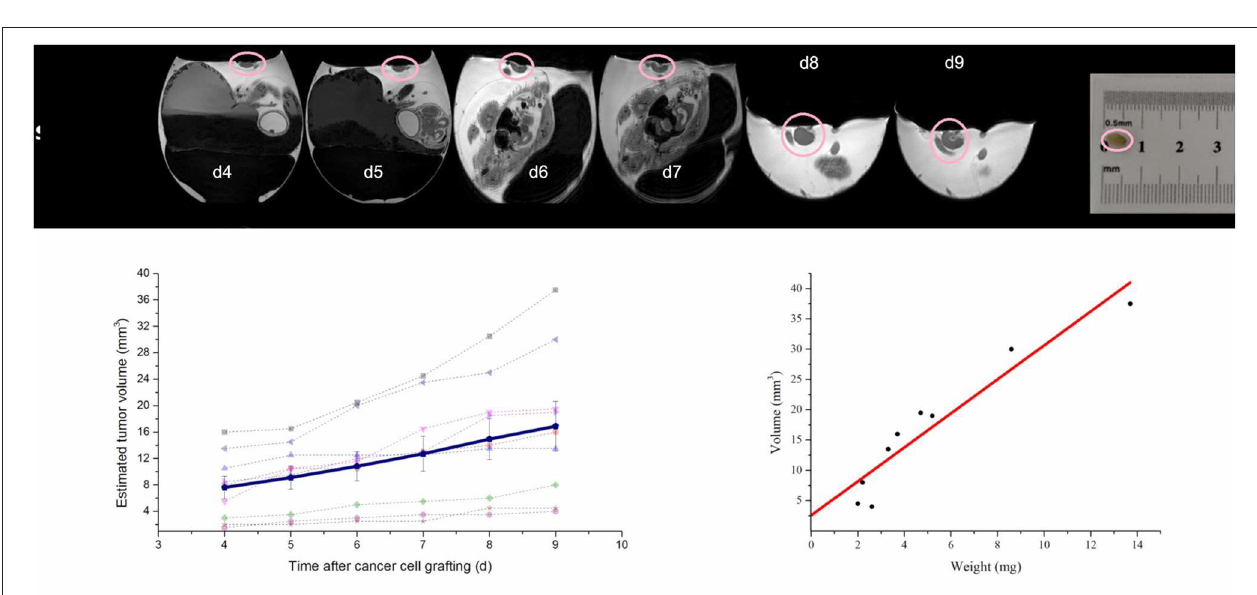
FIGURE 7 | Monitoring the progression of xenotransplanted tumor (circle) from day 4 to day 9 after cell seeding on the CAM. (Top) High-resolution T2 weighted MR images; (lower left) individual tumor volumes ( n = 9) and mean volume progression (solid line); (lower right) correlation of tumor volume ( n = 9) and weight after tumor resection at day 9. Modified from original research published in NMR Biomed: High-resolution MRI analysis of breast cancer xenograft on the chick chorioallantoic membrane. Zuo et al. [61].